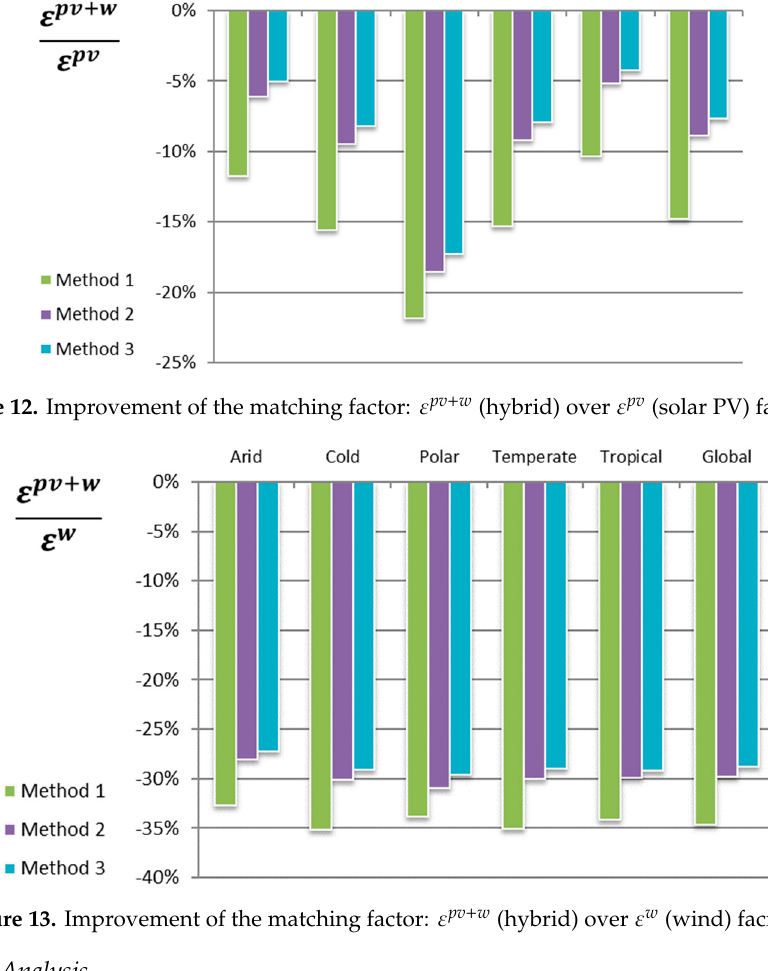
Figure 13. Improvement of the matching factor: ε pv + w (hybrid) over ε w (wind) facilities.